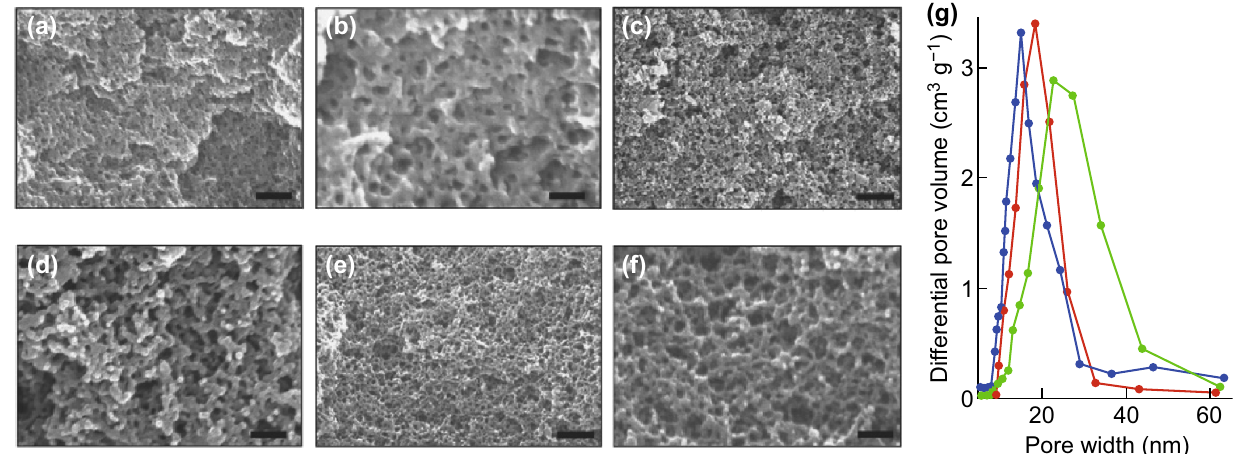
Fig. 16 a – f SEM images of HKUST-1 synthesised in CO 2 -expanded DMF. a , b 2.0; c , d 4.5; e , f 6.6 MPa. Scale bars, 150, 50, 500, 150, 500, and 150 nm for a – f , respectively. g The mesopore size distribution curves for the Cu 3 (BTC) 2 synthesised in CO 2 -expanded DMF at 2.0 MPa (blue curves), 4.5 MPa (red curves) and 6.6 MPa (green curves). Reprinted with permission from Peng et al. [114]. Copyright CC BY-NC-SA 4.0. (Color figure